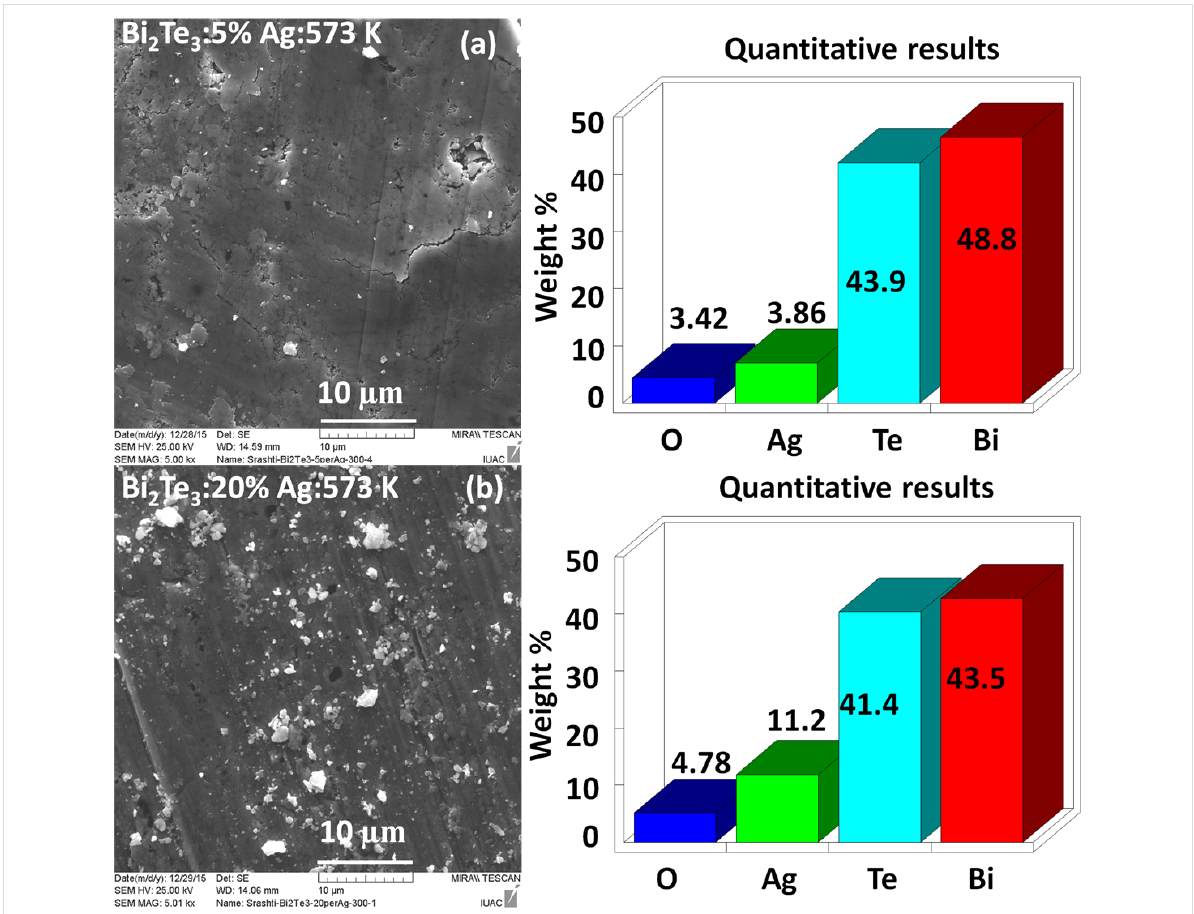
Figure 2: SEM and SEMEDS images of Bi 2 Te 3 with (a) for 5% Ag, (b) for 20% Ag annealed at 573 K.